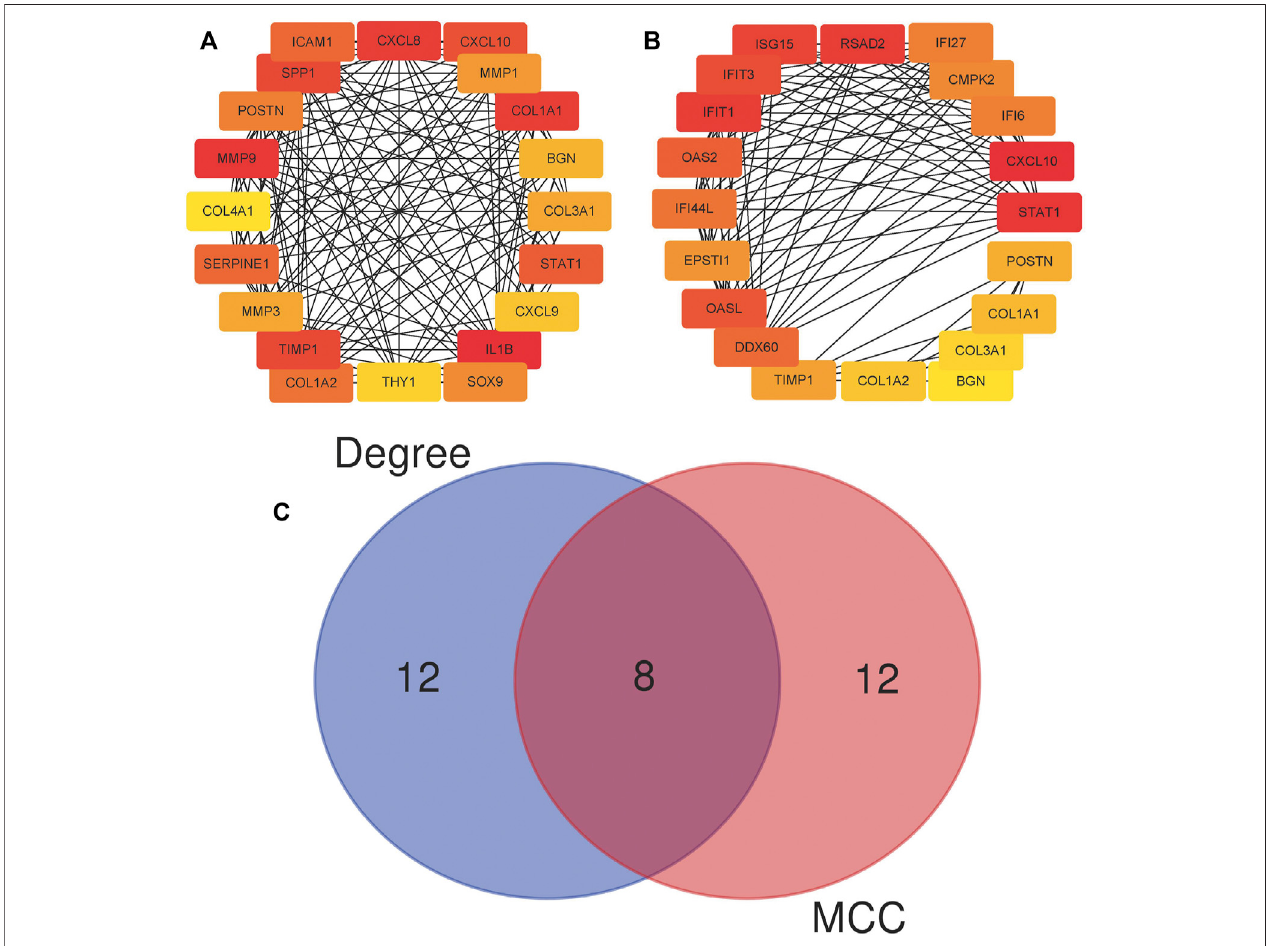
FIGURE 3 | Twenty hub genes calculated using the cytoHubba plugin. (A) Twenty hub genes based on the degree algorithm. (B) Twenty hub genes based on the MCC algorithm; MCC, Maximal Clique Centrality. (C) Wien diagram of hub genes attained from two algorithms.